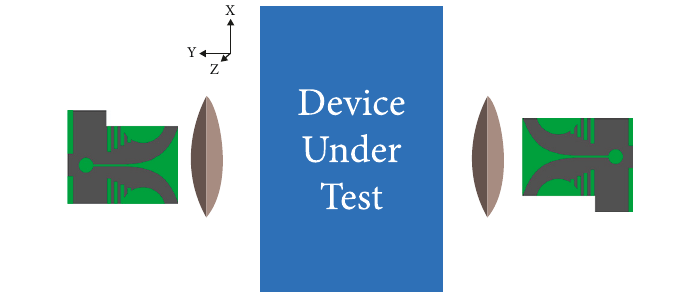
Figure 10: Structure of measuring platform.